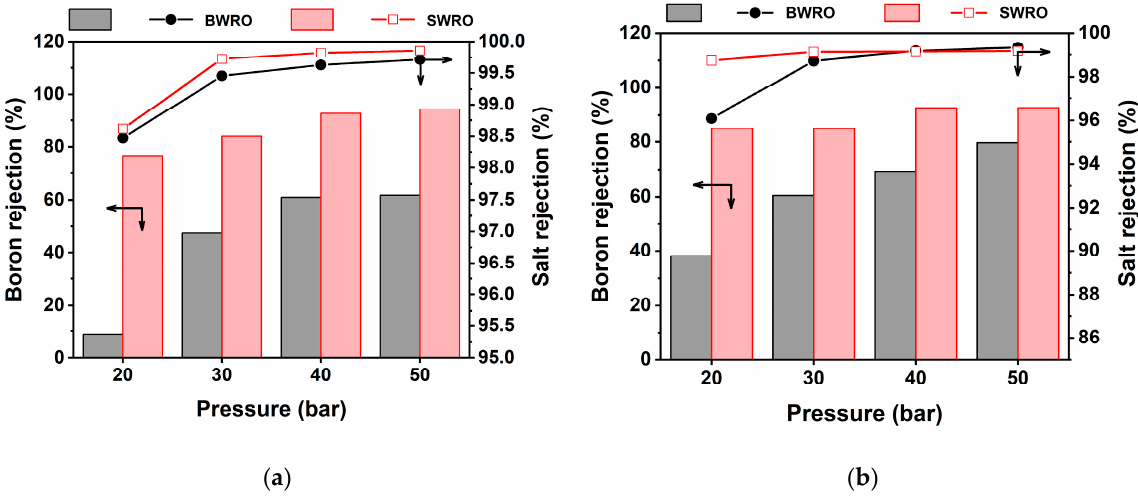
Figure 7. Boron and salt rejection by applied hydraulic pressure and membrane types (SWRO and BWRO) in feed concentration of ( a ) 20,000 mg/L and ( b ) 15,000 mg/L.